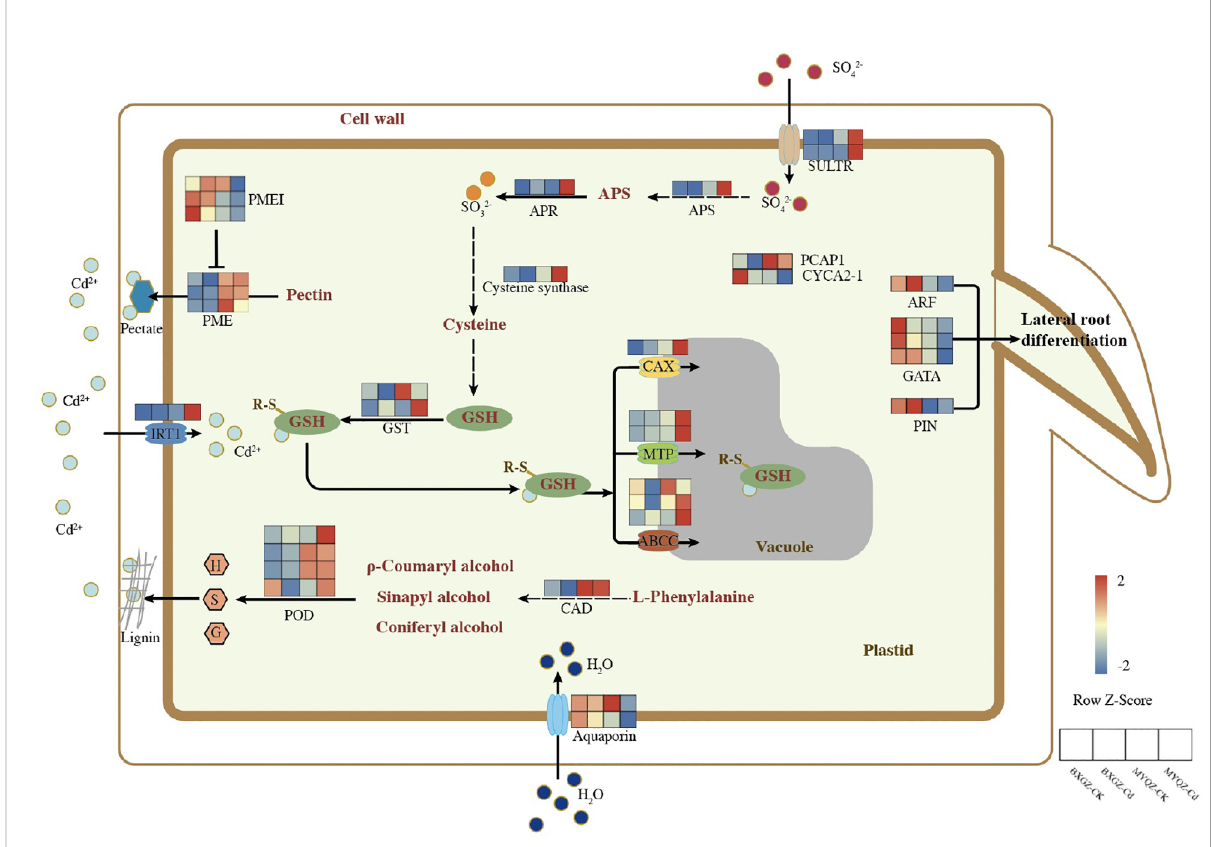
FIGURE 3 The schematic diagram of DEG in response to Cd stress between different treatments in the roots of BXGZ and MYQZ. The expression heatmap was arranged as BXGZ-CK, BXGZ-Cd, MYQZ-CK, and MYQZ-Cd from left to right. The expression level of each DEG was averaged by the 3 biological samples and then normalized to a